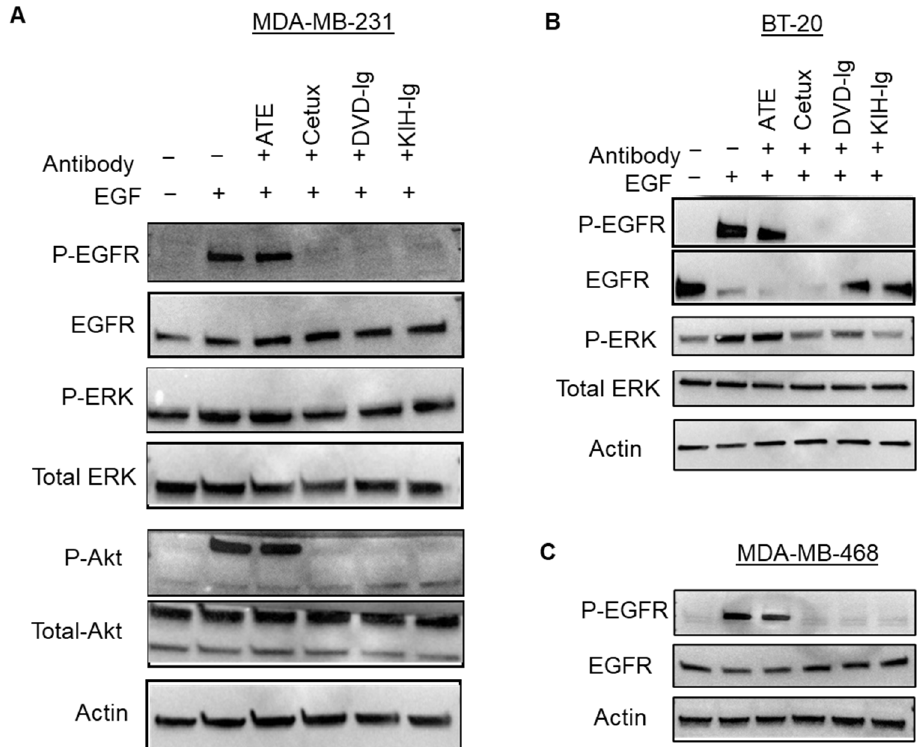
Figure 8. Anti-EGFR/PD-L1 BsAbs inhibited ligand-induced signaling in TNBC cells. MDA-MB-231 ( A ), BT-20 ( B ) and MDA-MB-468 ( C ) cells were subjected to serum starvation overnight and then pre-treated with anti-EGFR/PD-L1 BsAbs and parental mAbs. After antibody treatment, cells were exposed to EGF for 30 min at a concentration of 50 ng/mL. After treatments, cells were lysed in lysis buffer to prepare whole-cell lysate (WCL), and samples were subjected to western blotting to determine the phosphorylation levels and total protein levels of indicated signaling molecules. Actin expression was performed to measure equal loading. Unprocessed western blots images of ( A – C ) are provided in Sup- plementary Figure S2.